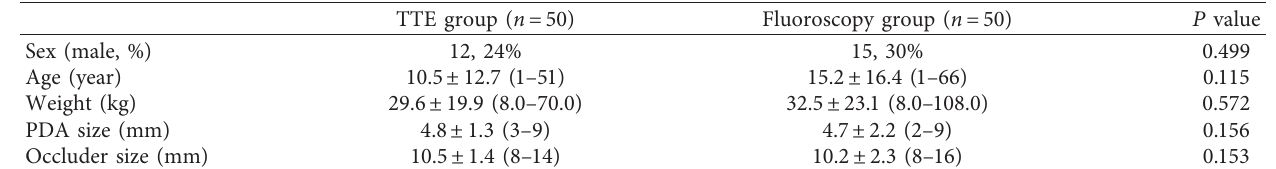
Table 1: General patient, defect, and device characteristics.